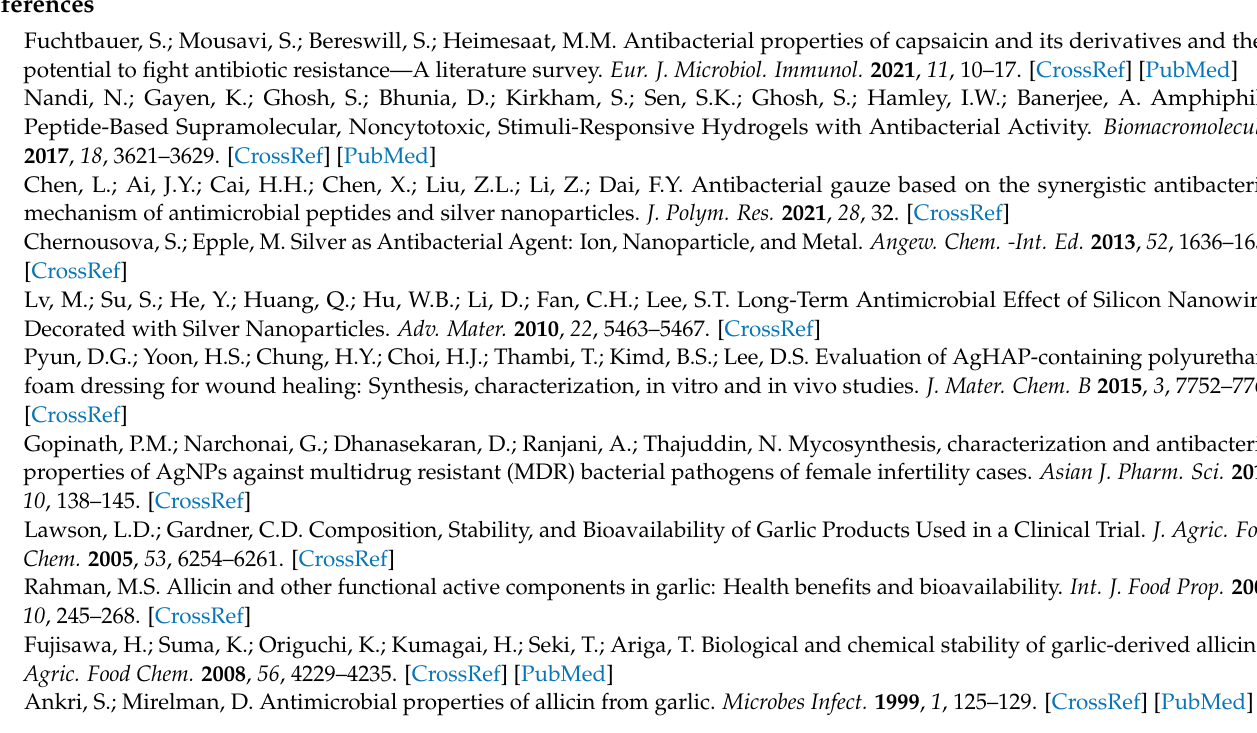
35 ◦ C; Figure S4: Water absorption of the antibacterial patches; Figure S5: Photographs of the process of establishing a mice wound model. (a) Photographs of shaved mice. (b) Photographs of mice injected with B. subtilis. (c) Mice with "Antibacterial